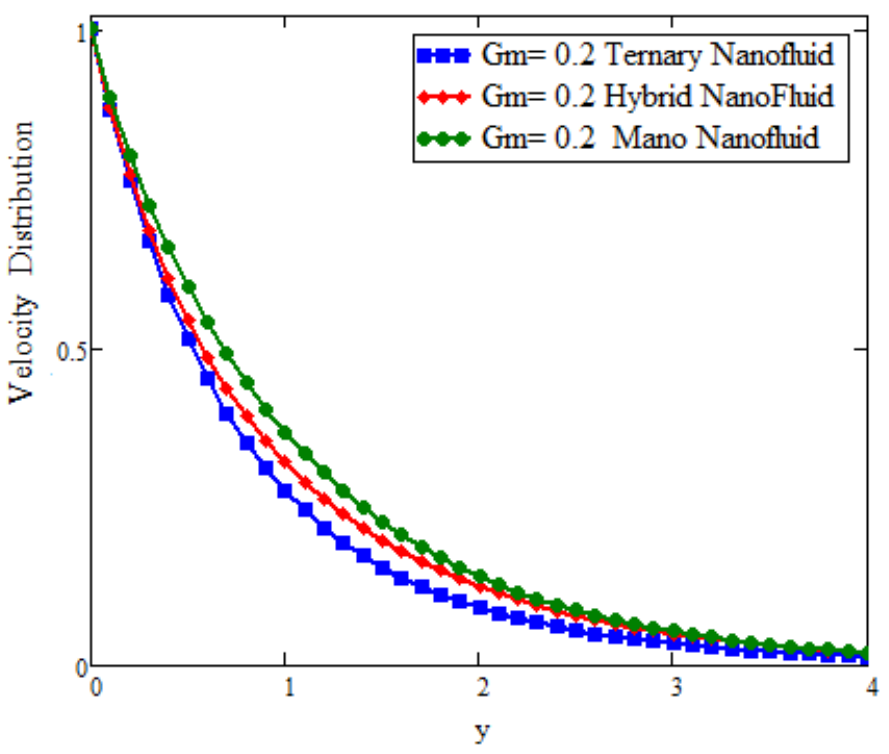
Figure 6. Comparison of velocity assessment with Gm across y as α = β = γ = 0.5 when t = 1, Sc = 9.2, φ 1 = 0.02, φ 2 = 0.03, φ 3 = 0.04, Pr = 21, and M = 1.5.